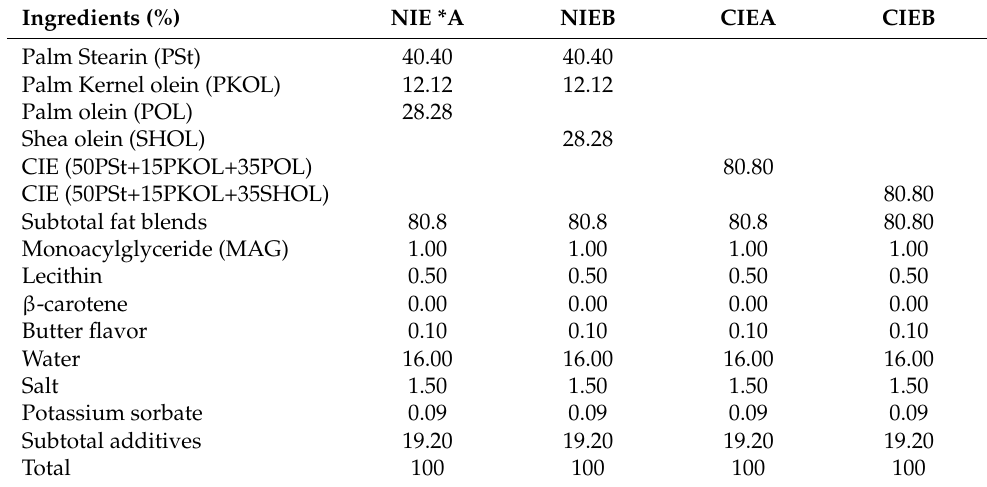
Table 1. Commercial Formulations of samples NIEA, NIEB, CIEA, and